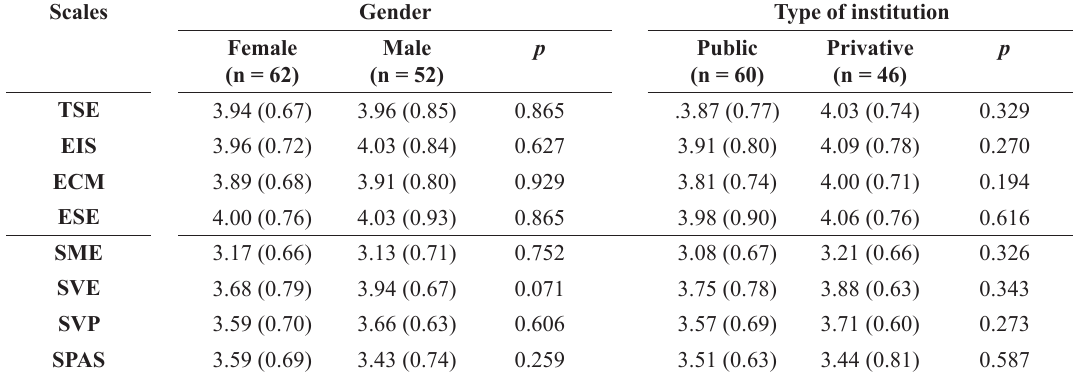
Table 3. Spearman correlation coefficients on teacher self-efficacy and its dimensions, sources of teacher self-efficacy, and context variables (n=114).